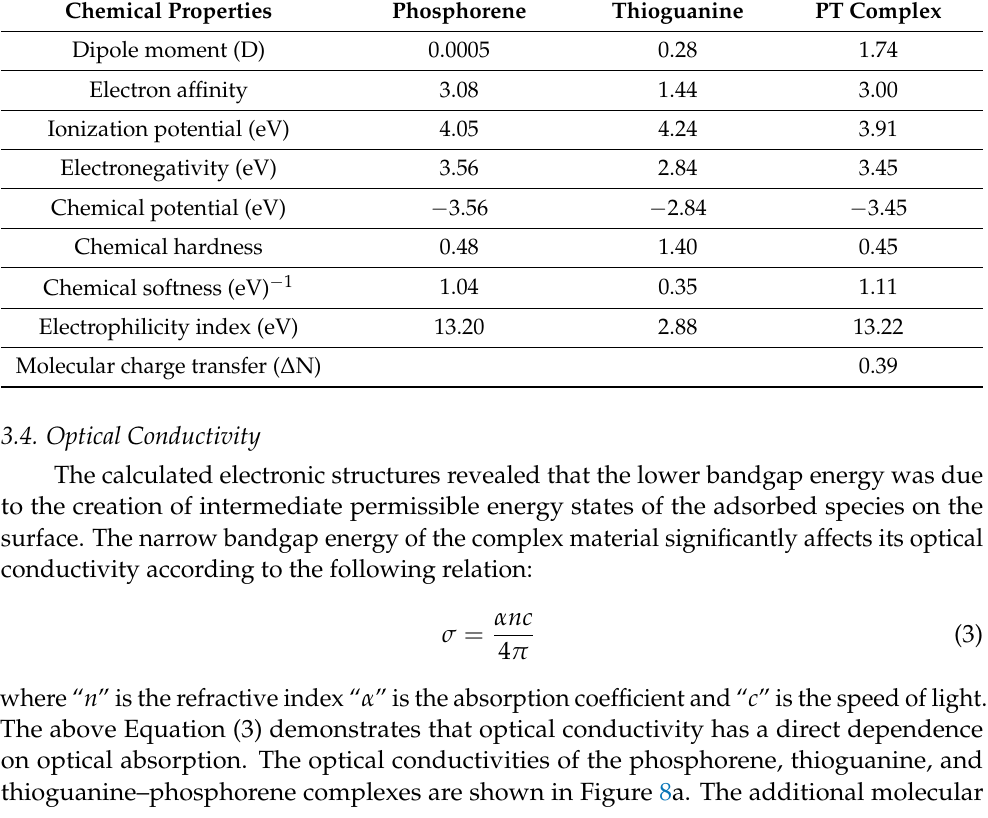
Table 2. Calculated values of dipole moment (D), electron affinity, ionization potential, electronega- tivity, chemical potential, chemical hardness, chemical softness, electrophilicity index (all in eV), and molecular charge transfer of phosphorene, thioguanine, and their complex. Chemical Properties